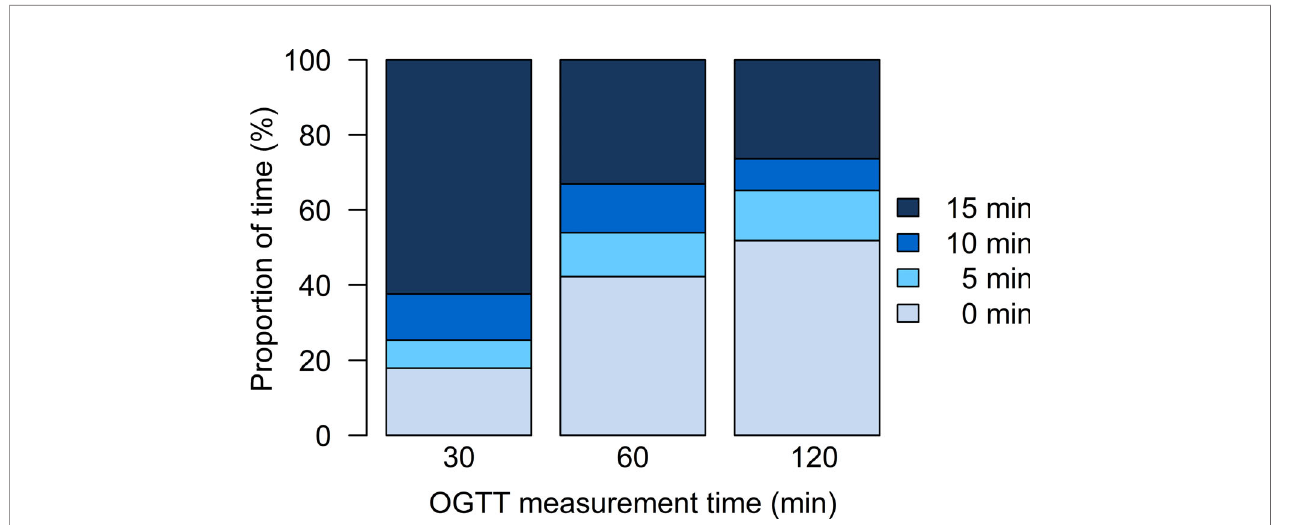
FIGURE 2 | Distribution of possible time-lags (0, 5, 10 or 15 min) of the corresponding CGM measurement for each of the post-challenge OGTT glucose